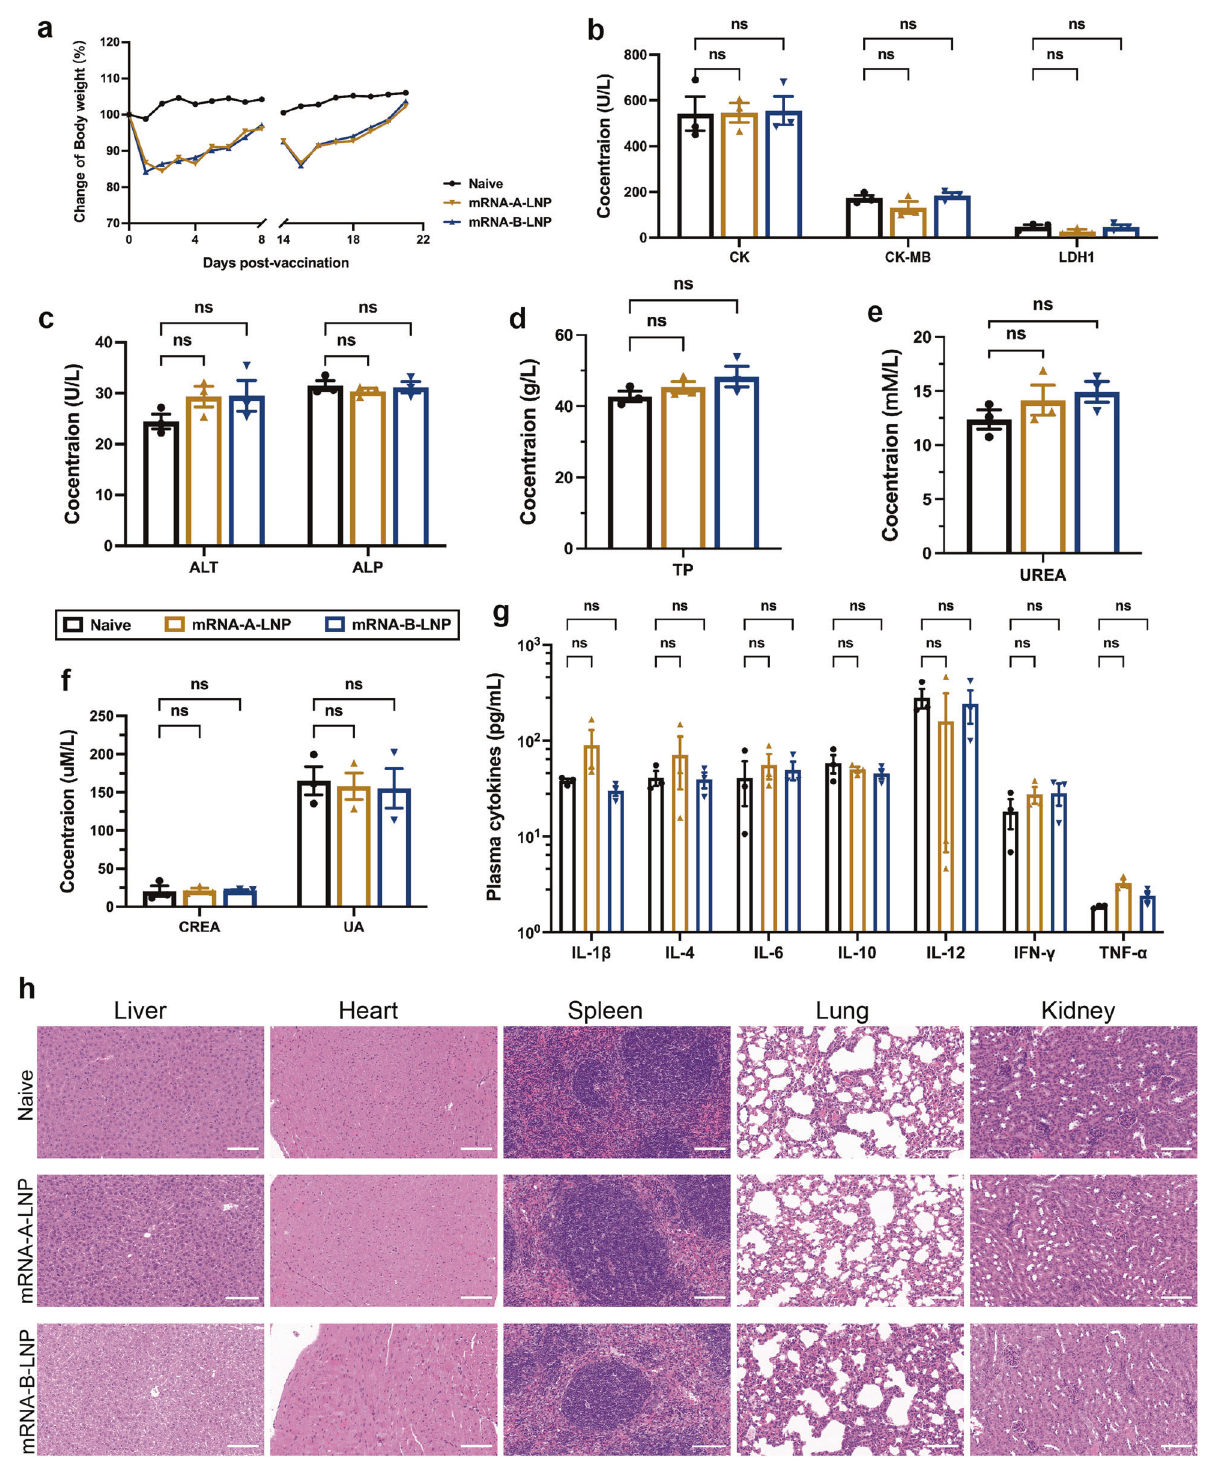
Fig. 5 The safety evaluation of MPXV quadrivalent mRNA vaccine in mice. a The body weight records of mice on the fi rst eight days after each vaccination. b – f Heart, liver and kidney function were determined by blood biochemical parameters ( n = 5). CK, CK-MB and LDH1 represent heart function ( b ), ALT, ALP and TP represent liver function ( c , d ), while UREA, CREA and UA represent kidney function ( e , f ). g The immune activation effect of the vaccine was expressed by analysis of cytokines in innate immunity ( n = 5). h Representative histopathology (H&E) of different tissues, liver, heart, spleen, lung and kidney from naive mice or mRNA vaccine-immunized mice. The H&E stained sections shown in the data are representative results from three test mice 48 h post-inoculation. Scale bar = 100 μ m, 30×. Data are shown as mean ± SEM. Signi fi cance was calculated using two-way ANOVA with multiple comparison tests (n.s., not signi fi cant; * p < 0.05, ** p < 0.01)